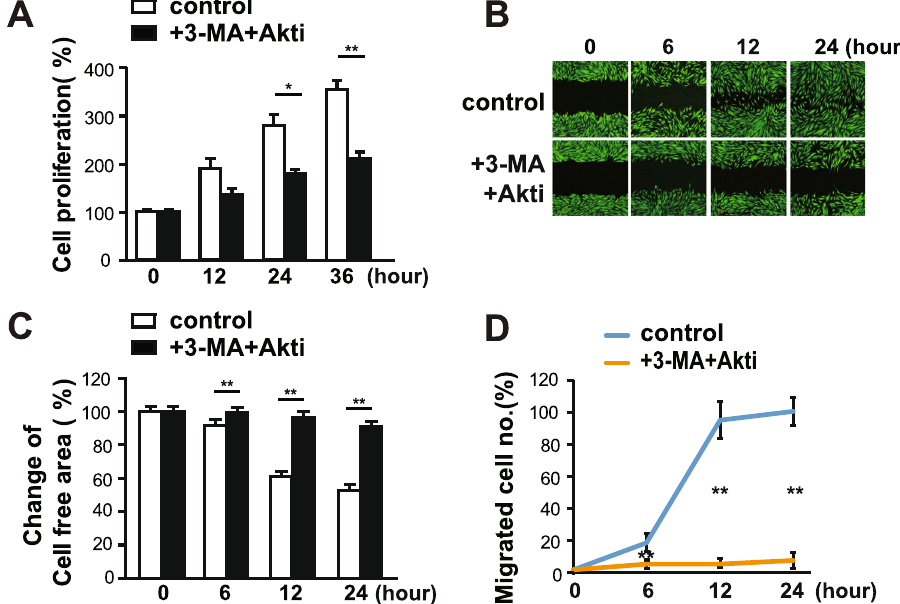
Figure 6. Both Akt and autophagic flux regulated cell migration under SM condition in human eSCs. ( A ) The cells were incubated with or without both 10 mM 3-MA and 1 μ M Akti for the indicated times and counted using a cell counter. ( B – D ) The cells were scratched with a T200 tip and treated as in ( A ) for the indicated times. ( B ) The cells were stained using the CytoPainter Cell Tracking Staining kit and photographed. ( C ) The cell-free areas were measured using ImageJ and changes in cell-free areas were calculated. ( D ) The number of migrated cells was counted using ImageJ. Abbreviations: simulated microgravity (SM); 3-methyladenine (3-MA). Data are expressed as mean ± SD, with paired t -tests performed as indicated. * P < 0.05, ** P < 0.01 versus control at each indicated